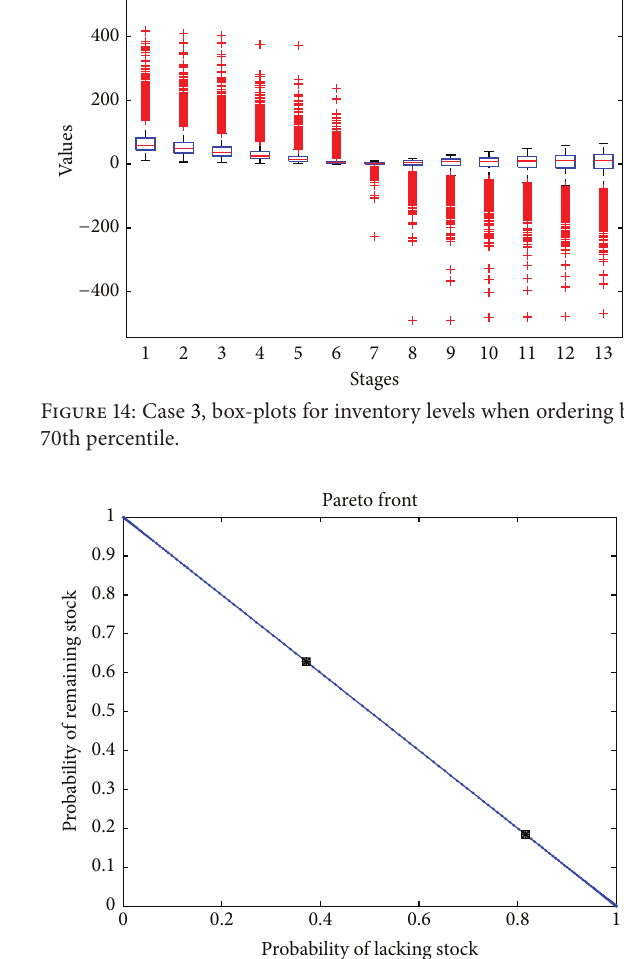
Figure 15: Case 3, Pareto front for trade-off between the probabili- ties of having and not having